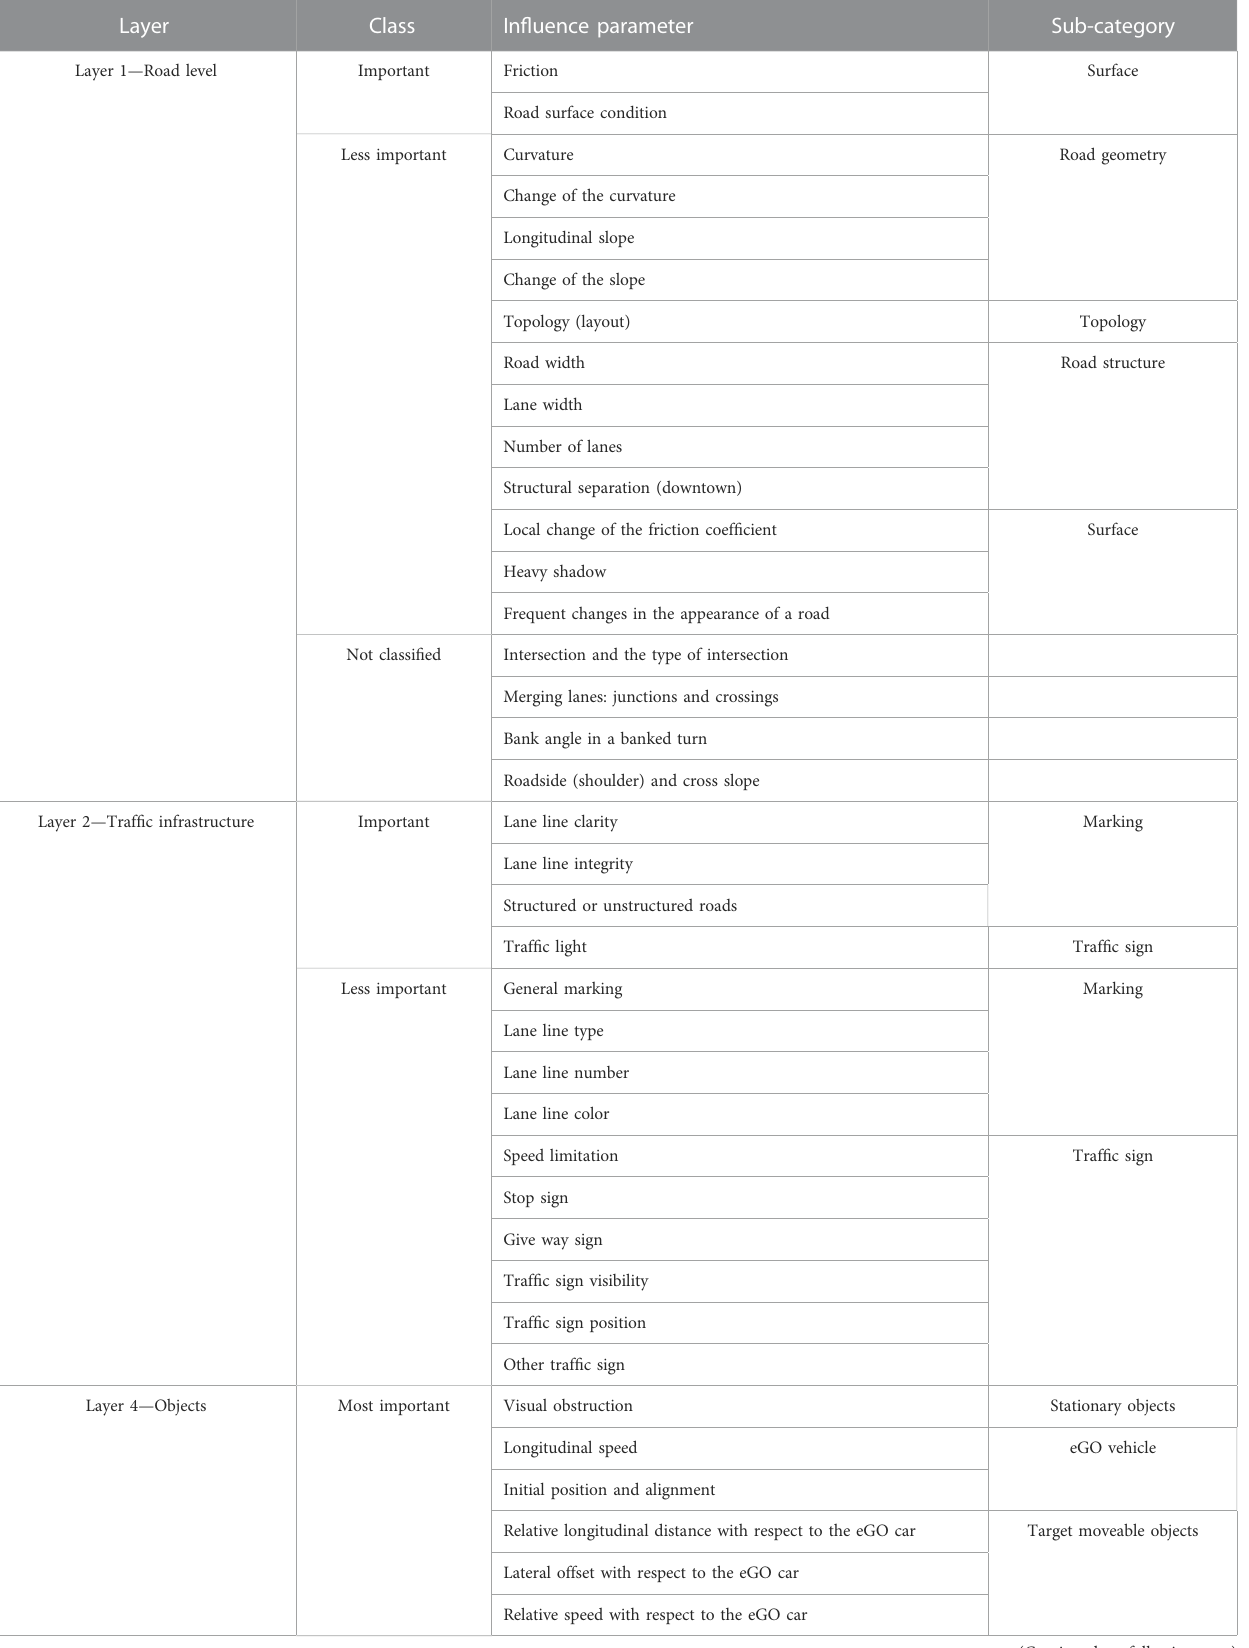
TABLE 7 In fl uence parameter list with categorization and classi fi